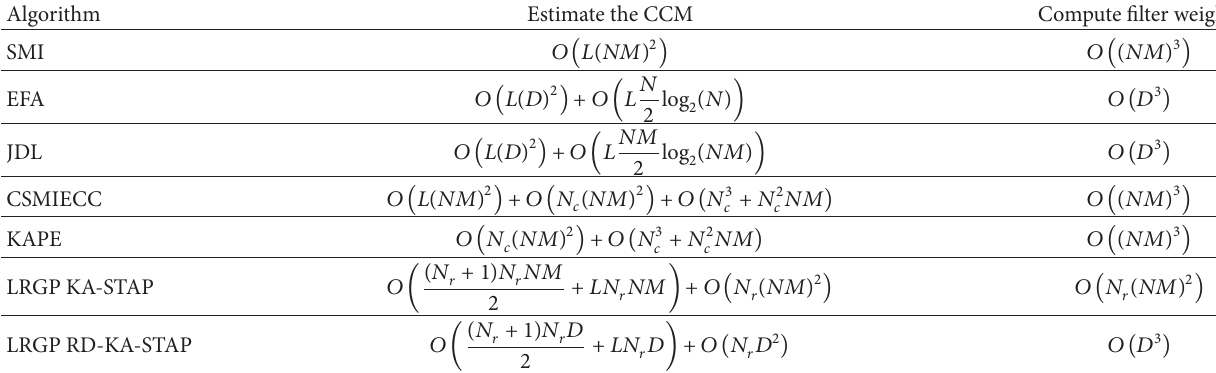
Table 1: Computational complexity of